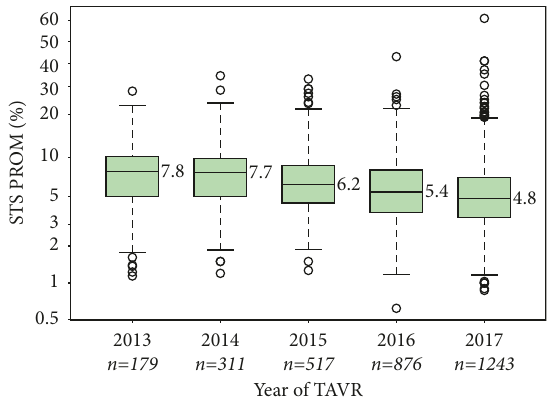
Figure 1: STS PROM of patients undergoing transcatheter aortic valve replacement procedures. Society of Thoracic Surgeons pre- dicted risk of mortality (STS PROM) scores for all transcatheter aortic valve replacement (TAVR) procedures performed in nine hospitals in a five-year period are shown. Values are displayed as medians (middle bars) and interquartile ranges (solid boxes) on a logit scale.